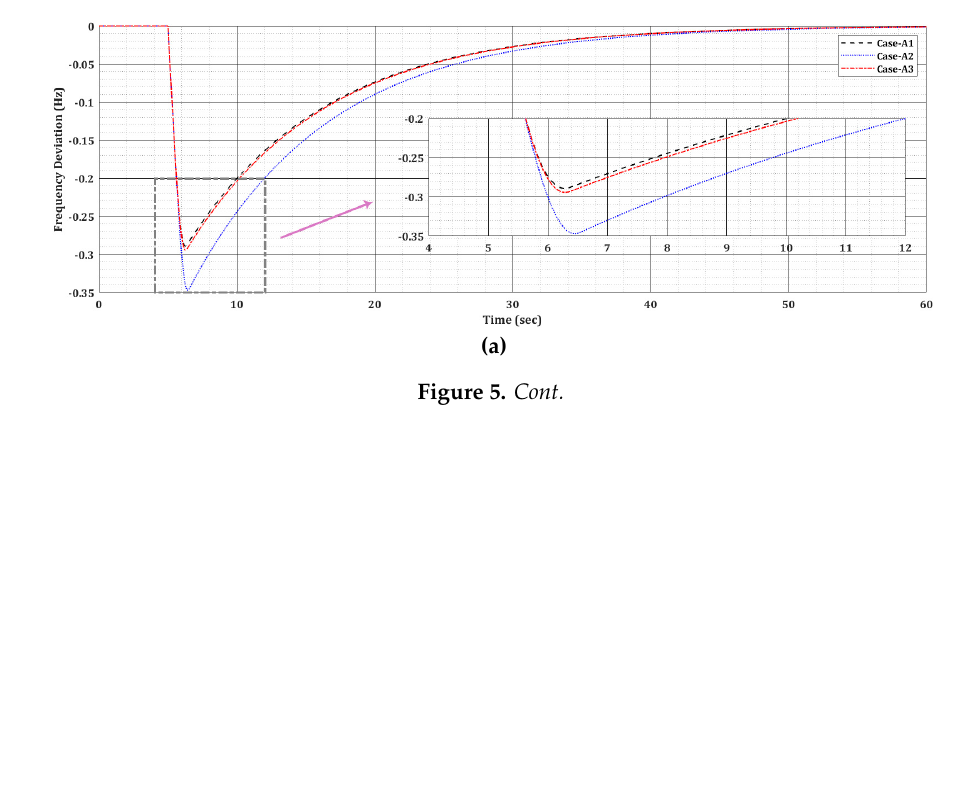
Figure 4. 3-machine test system for numerical simulations.